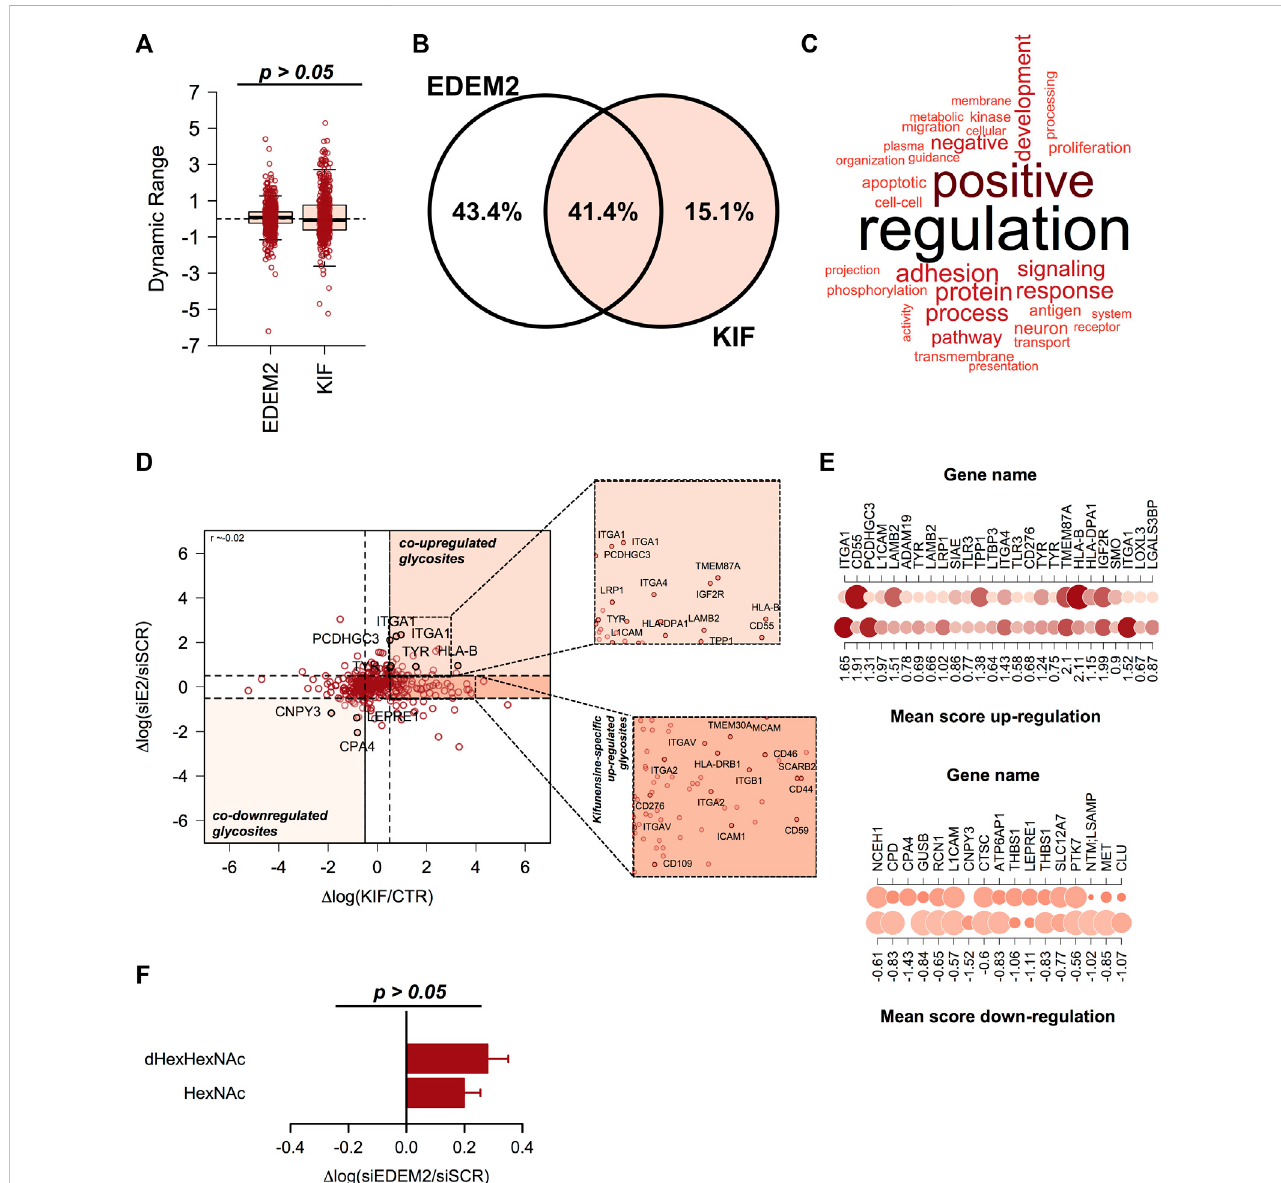
FIGURE 4 ComparisonanalysisofkifunensineandsiEDEM2treatedcells. (A) Boxplotof therelativelogfoldchangesbetweencellstreatedandtheircorresponding controls. No major changes were observed, except for a slightly larger distribution for the current dataset. (B) Venn Diagram of the glycosites identi fi ed in each of the analyzed datasetsorinbothexperiments. (C) GeneOntology(GO)analysisoftheBiologicalProcess(BP)termsassociatedwiththeglycoproteinsidenti fi edinthemergeddataset. (D) Distribution of the relative changes between the two analyzed conditions: log KIF/CTR and respectively log siEDEM2/siSCR. Each point denote a quanti fi ed glycosite in both experiments. Shown are some hits found up-/down-regulated in both experiments. Upper-inset: Zoom-in view with up-regulated glycosites in both datasets. Lower-inset: Zoom-in view for up-regulated glycosites only in this dataset. (E) Representation of the mean score for glycosites found up-regulated in both experiments(left-panel)anddown-regulatedinbothsiEDEM2andKIFtreatedcells(rightpanel). (F) Analysisofthefucosylatedglycositesandofthecorrespondingnon- fucosylated glycosites from the same glycoproteins from EDEM2 dataset. Bars are mean of the core-fucosylated glycosites ( n = 30) and their corresponding non- fucosylated glycosites ( n = 68) from the same glycoproteins and error bars are